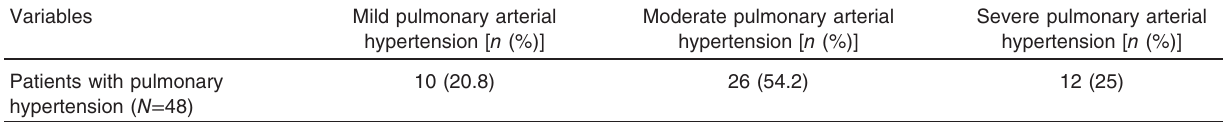
Patients are said to have pulmonary hypertension when pulmonary artery systolic pressure (PASP) is more than or equal to 35 mmHg. Patients were categorized into mild (PASP = 35 – 50), moderate (PASP = 50 – 70), and severe PH (PASP > 70). PASP, pulmonary artery systolic pressure; PH, pulmonary hypertension.